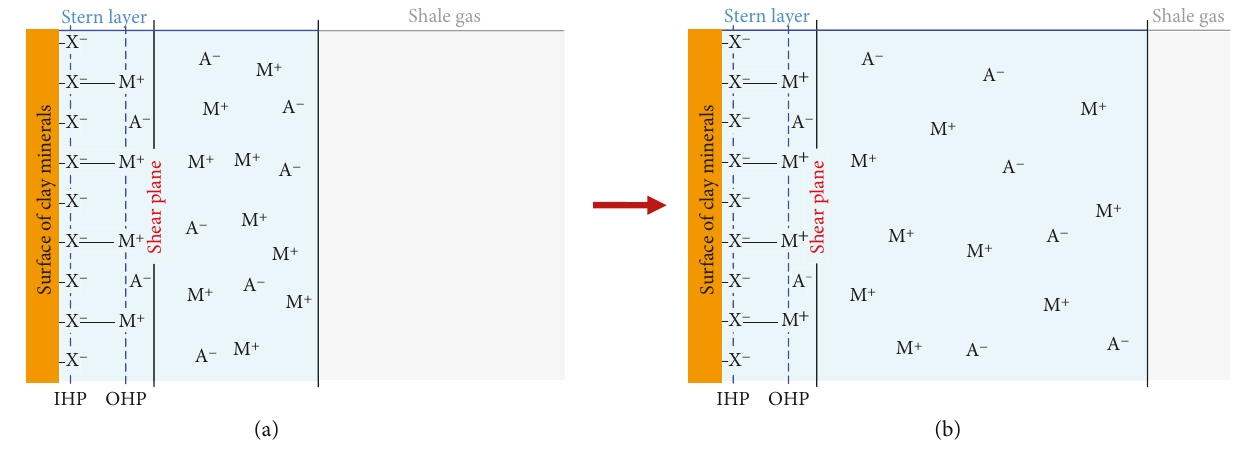
plus solute species and the nonwetting phase is shale gas. In the reference state, the water saturation is de fi ned by θ s , 1 = ϕ w where θ is the water content (volume fraction); ϕ is connected porosity. We denote by S the contact area between the shale solid sw phase and the wetting phase and by S the contact area nw between the nonwetting phase and the wetting phase. Q 0 represents the charge density of the surface minerals; Q β represents the charge density of the Stern layer; fi nally, Q S represents the charge density of the di ff use layer [26]. Q = Q + Q β S 0 Ignoring the gas/water interface charge, the porous shale electrical balance equation is